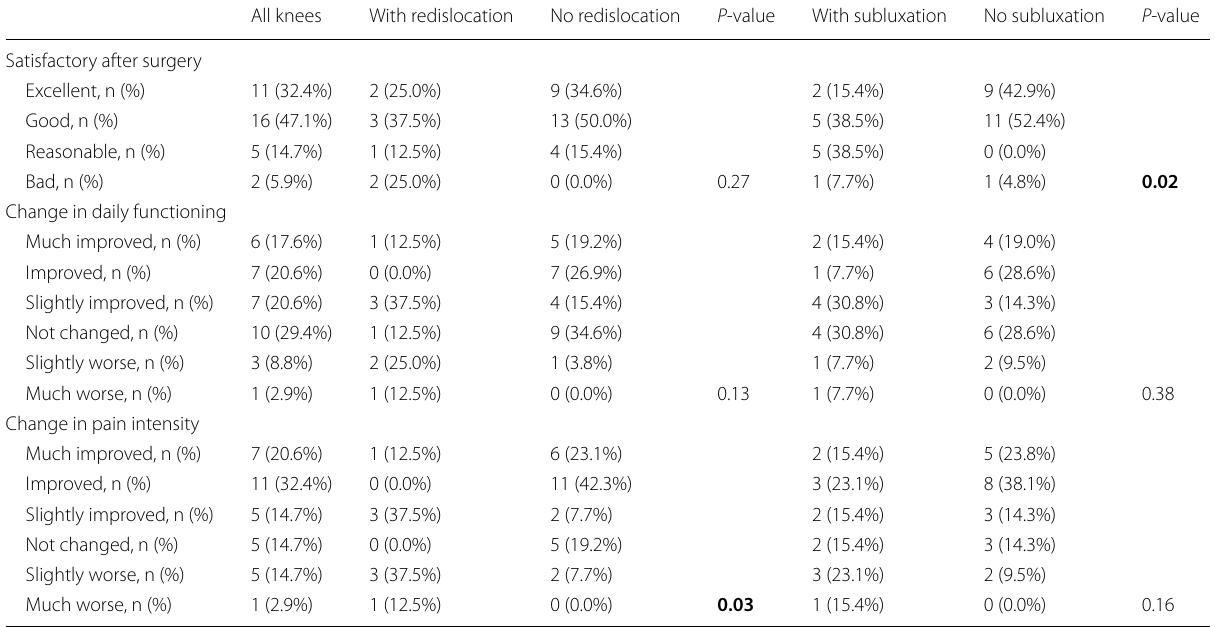
Table 4 Subjective